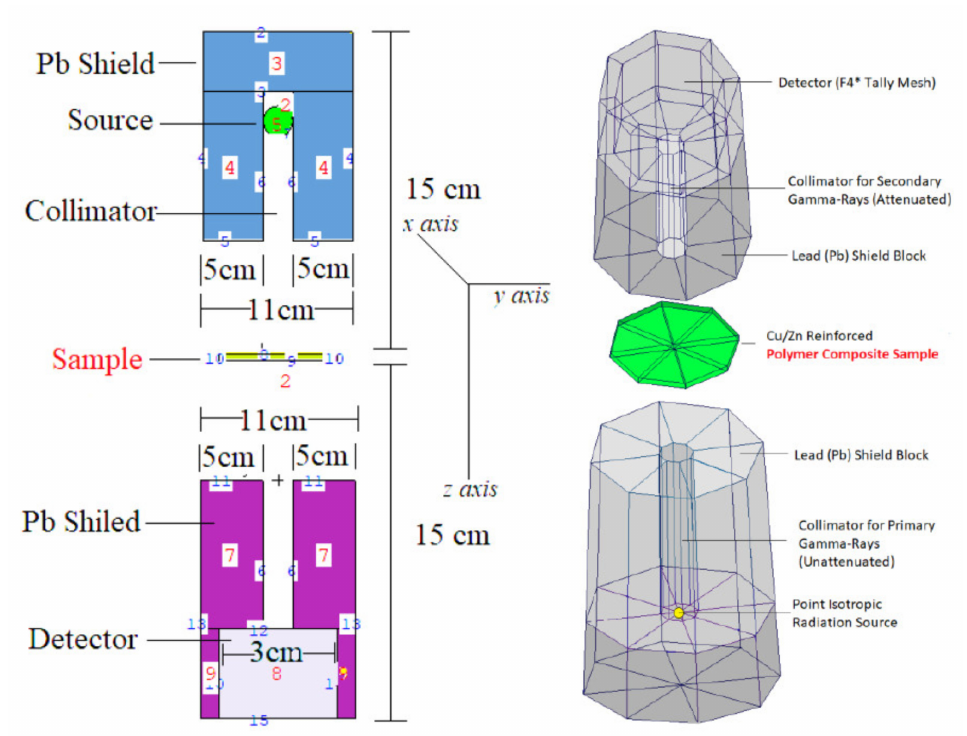
Figure 4. MCNPX simulation setup used for gamma-ray transmission simulations (a direct screenshot from the MCNPX Visual Editor VE X_22S